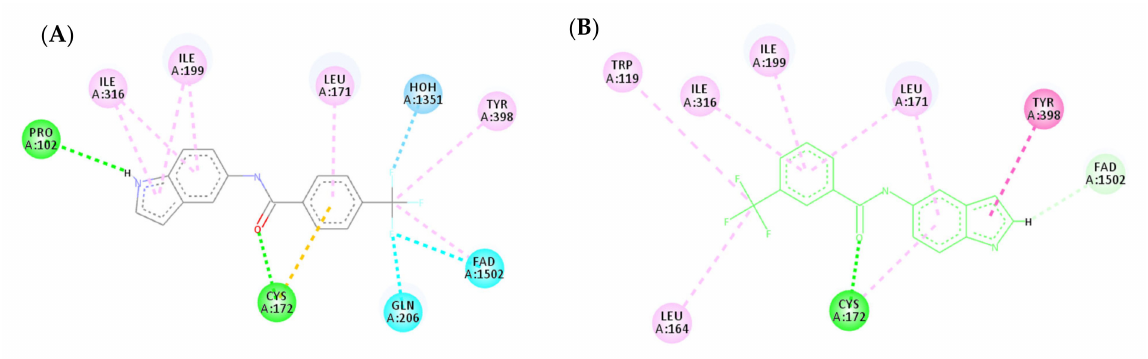
Figure 8. Predicted interactions of compounds 3v and 3u into the active site MAO-B. ( A ) Both compounds overlayed in the active site; ( B ) Interactions formed by compound 3v (gray); ( C ) Interactions formed by compound 3u (green).